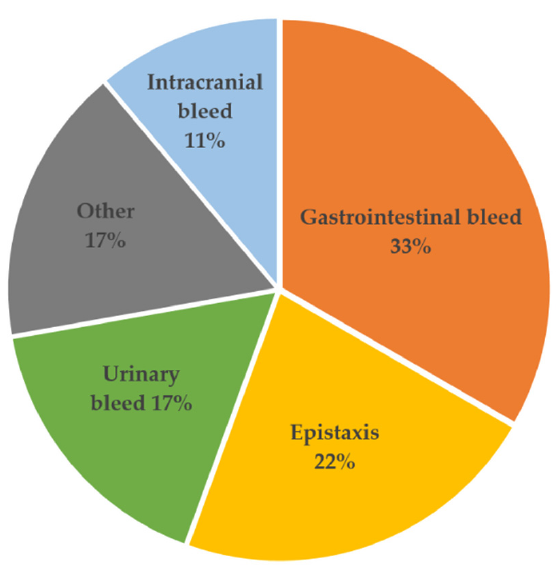
Figure 1. Percentage of types of bleeding after left ventricular assist device implantation in this study. Table 3. Detailed information of the first bleeding event after LVAD implantation in the bleeder group.